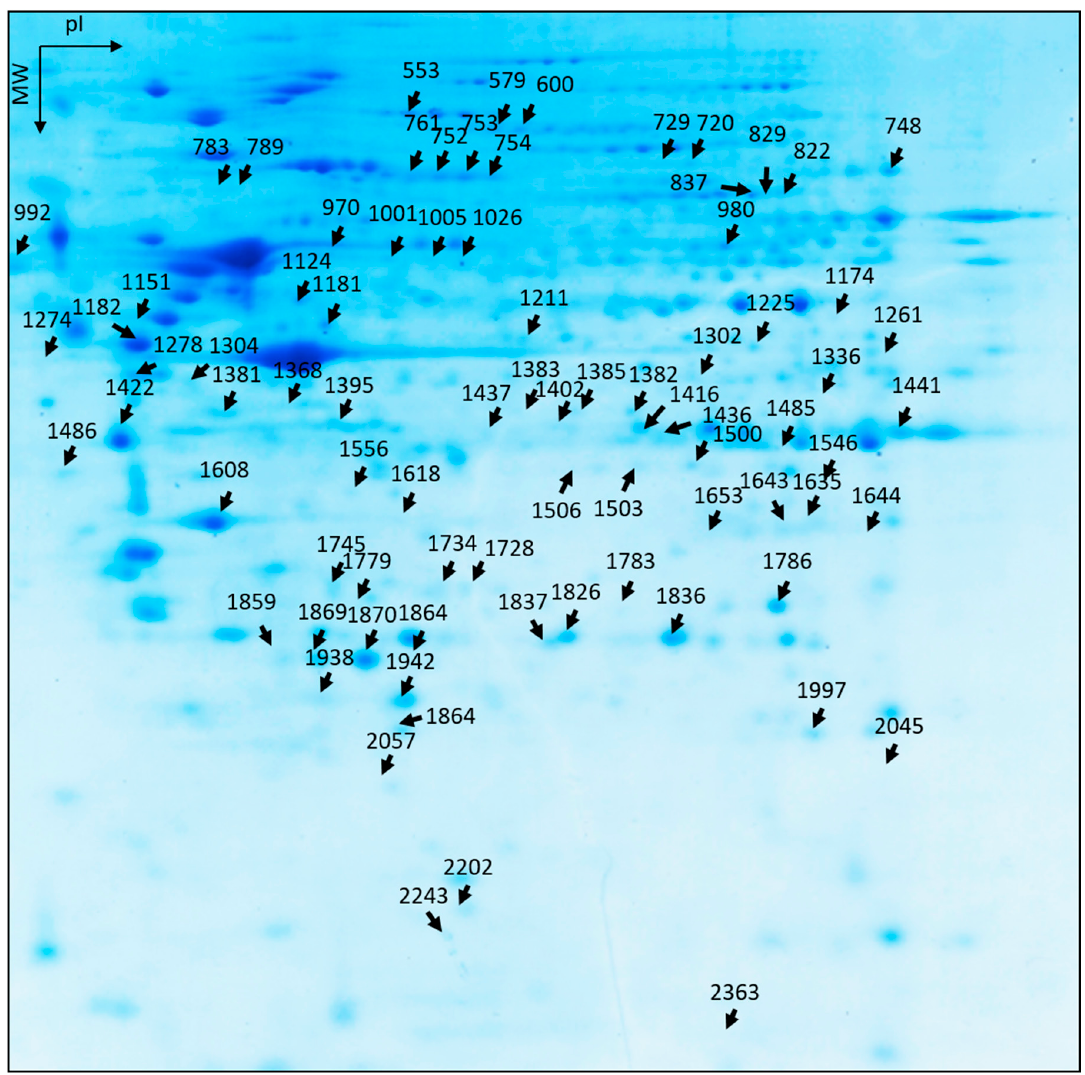
Figure 3. Spot position of the proteins of interest in the spot map of a blue-stained preparative 2D-gel. A quantity of 500 µ g of protein sample was separated on a 2D-gel. The identified spots were excised and sent for mass spectrometry